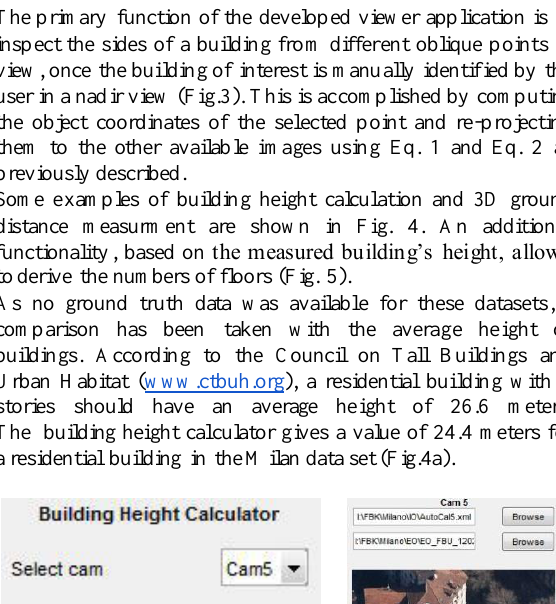
Figure 6. Building’s façade digitization.